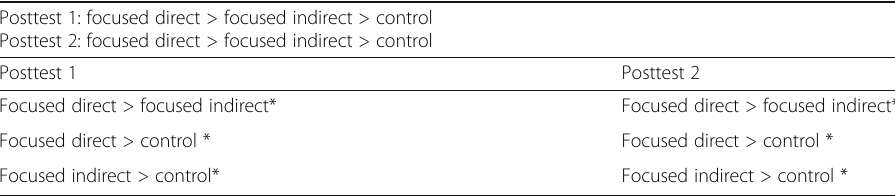
Table 8 SPSS output for the post-ANOVA analysis for the narrative writing task and text summary